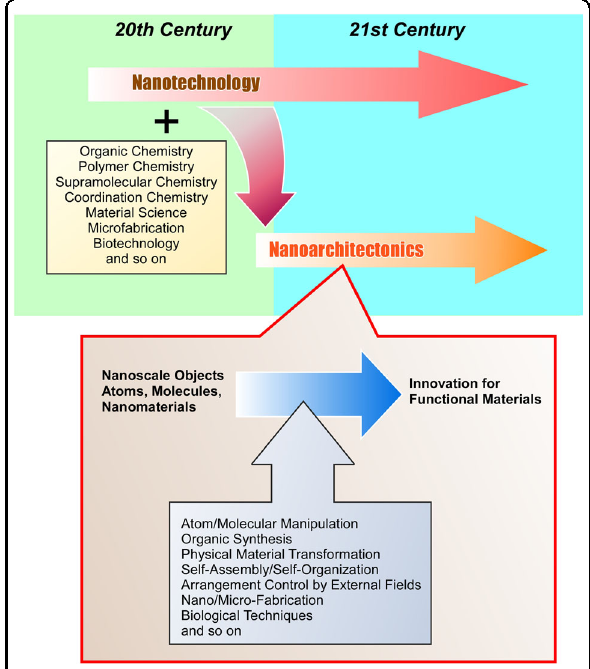
Fig. 1 Outline of nanoarchitectonics concept and